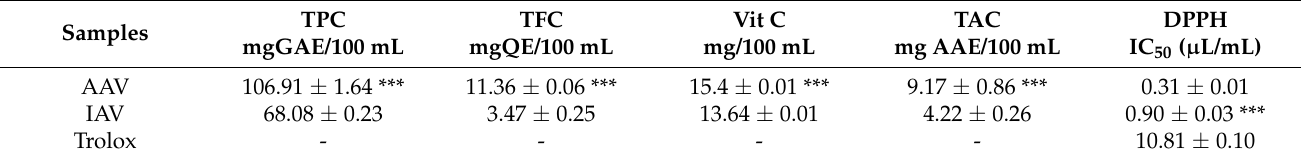
Table 3. Bioactive compounds and antioxidant activities of industrial and artisanal vinegars.